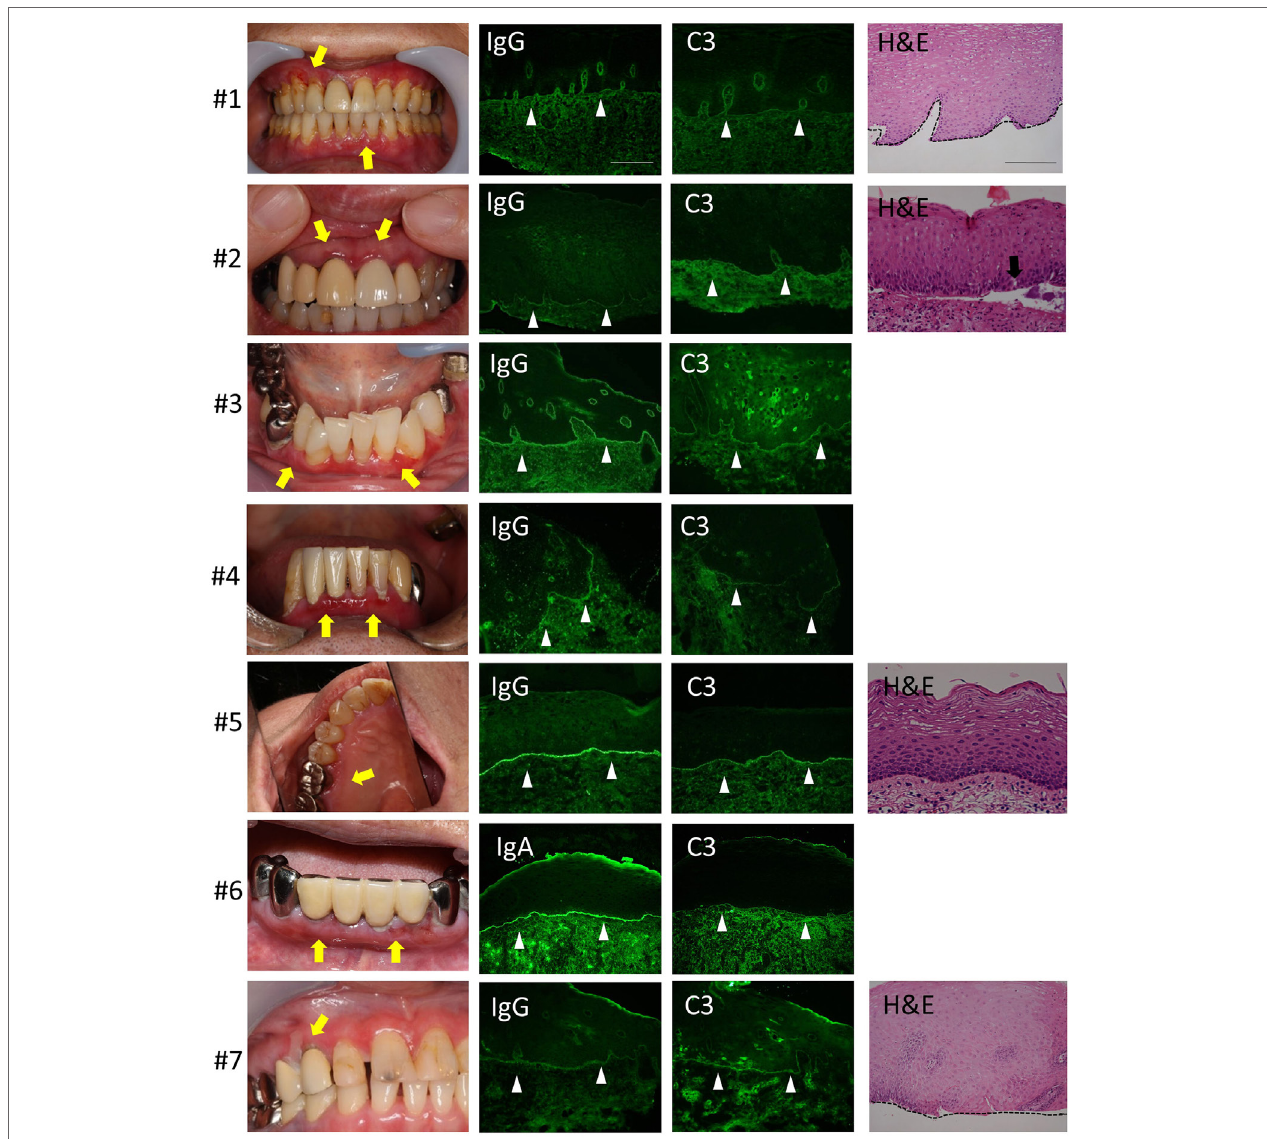
FigUre 2 | Clinical, histological, and direct immunofluorescence (DIF) findings. All the patients have gingival lesions (yellow arrows). The biopsy samples for DIF were taken from non-lesional buccal mucosa, and all samples shows the linear deposition of IgG or IgA, and C3 at the basement membrane zone (BMZ) in all cases (white arrow heads). Histological analysis shows the junctional separation at the BMZ (#3) (black arrow). The epidermal and dermal tissue are completely separated because of tissue destruction (#1,7). There is no evident separation at the BMZ (#5). Scale bar = 100